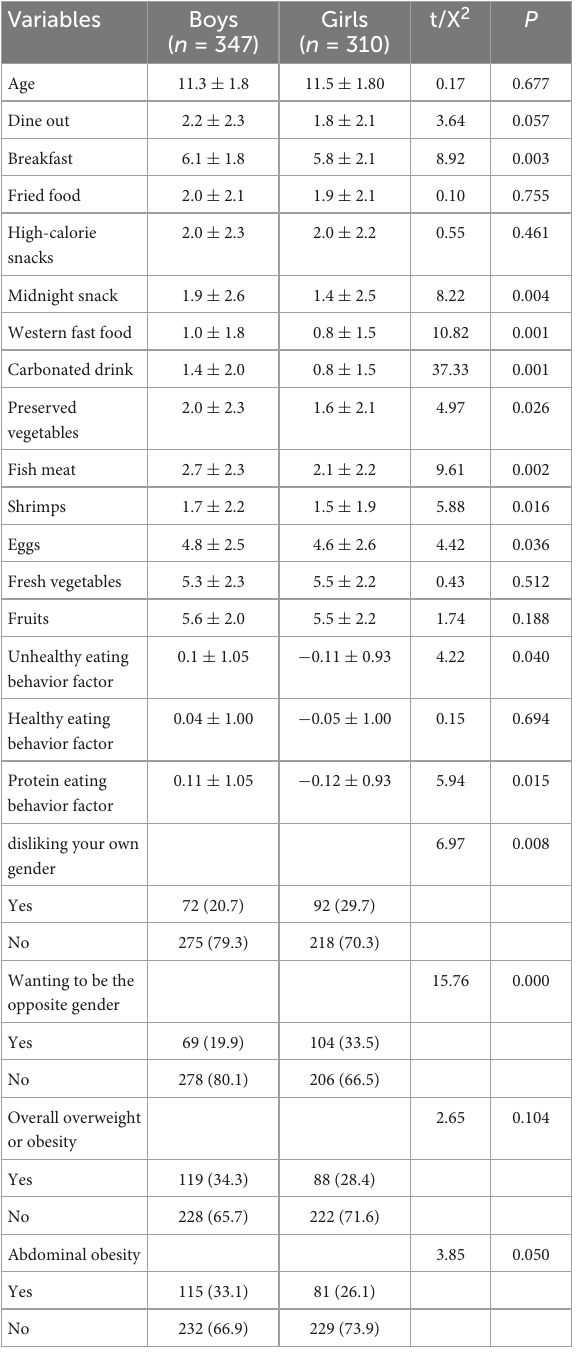
TABLE 2 Comparisons of differences in age, eating behaviors, gender want to be a member of the opposite gender? Answer: Not attitude, and body shape between boys and girls. wanting, Not completely wanting, Wanting (23). Wanting Variables Boys Girls t/X 2 ( n = 347) ( n = 310)